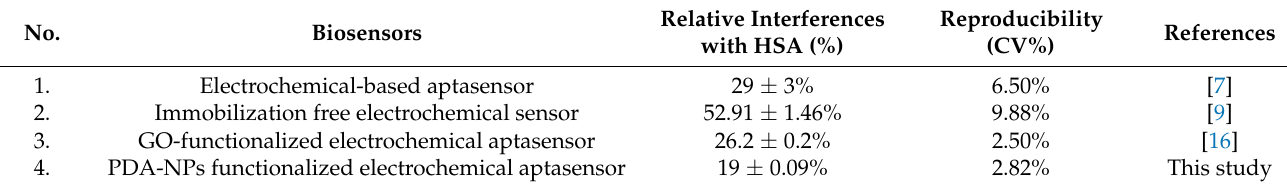
Table 3. Comparison of selectivity and reproducibility of the developed electrochemical sensor with other reported